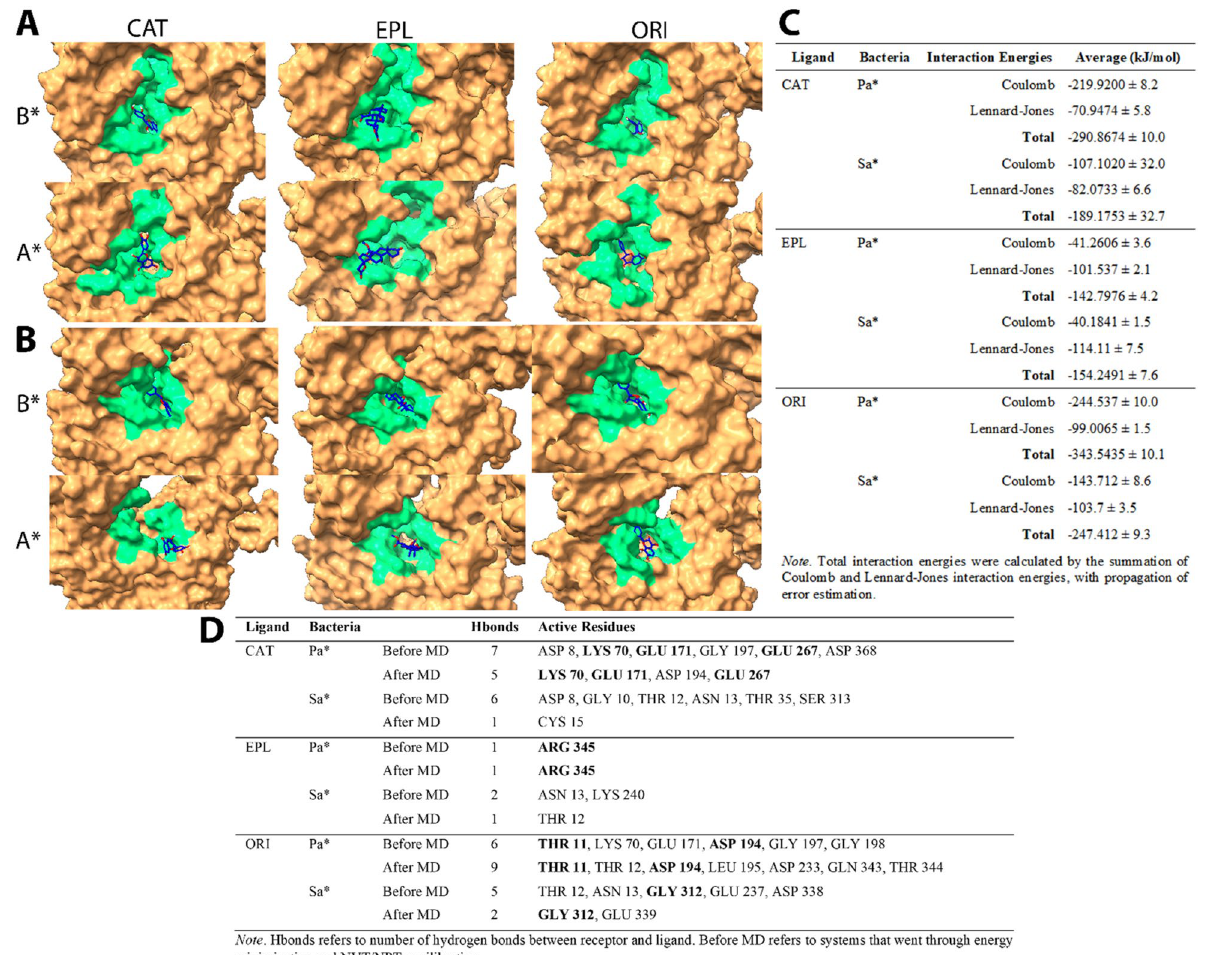
Figure 3. MD simulation of ( A ) P. aeruginosa and ( B ) S. aureus DnaK (brown)-Catechin(blue) complexes, of which P2Rank predicted druggable pocket residues were colored in green for better visualization. ( C ) Tabulated interaction energy values of DnaK-Catechin complexes. ( D ) Tabulated changes in number of hydrogen bonds and active residues before and after MD. Note B*—Before MD, A*—After MD, Pa*— P. aeruginosa , Sa*— S. aureus , CAT—Catechin, EPL—Eplerenone, ORI—Oritin-4-beta-ol. All data were generated using GROMACS 34 in-built